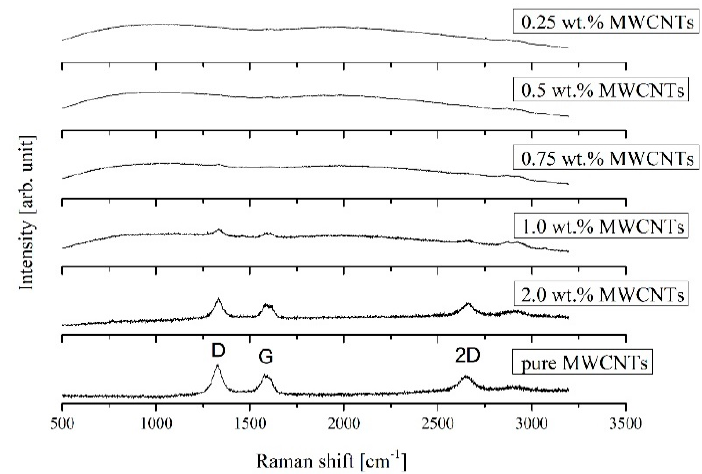
Figure 5. Raman shift for MWCNTs/epoxy composite samples with 0.25, 0.5, 0.75, 1.0, and 2.0 wt.% mass fractions of carbon nanotubes and pure MWCNTs for reference.